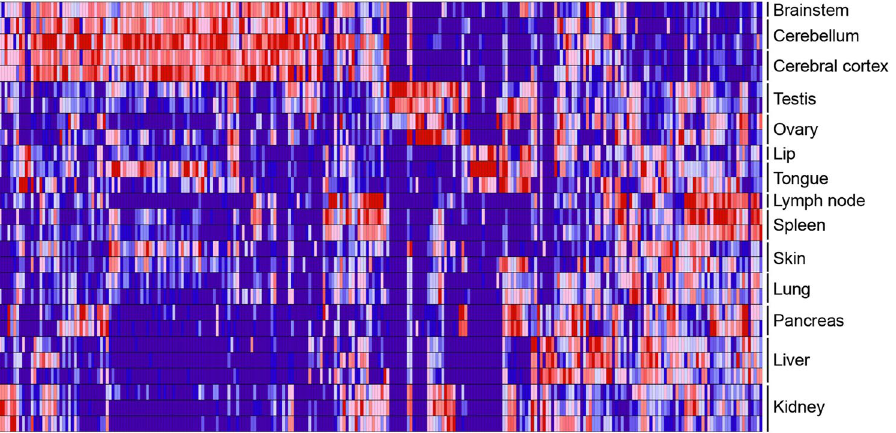
Figure 2. Heat map showing tissue-specific miRNA expression. Unsupervised hierarchical clustering was used to evaluate normalized expression of the most highly expressed mature miRNAs from each of the 271 precursors in all 27 samples. This analysis resulted in accurate clustering of all of the 27 samples within tissue types, as shown in the heat